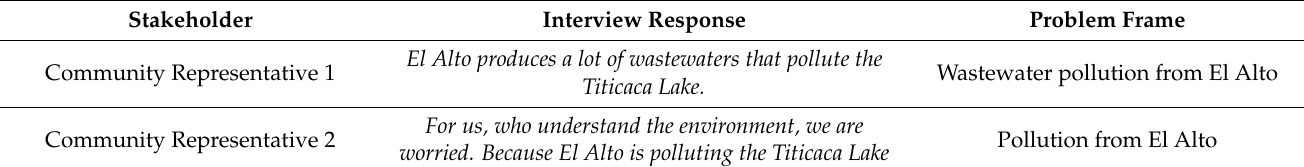
Table 3. Actor ´ s problem